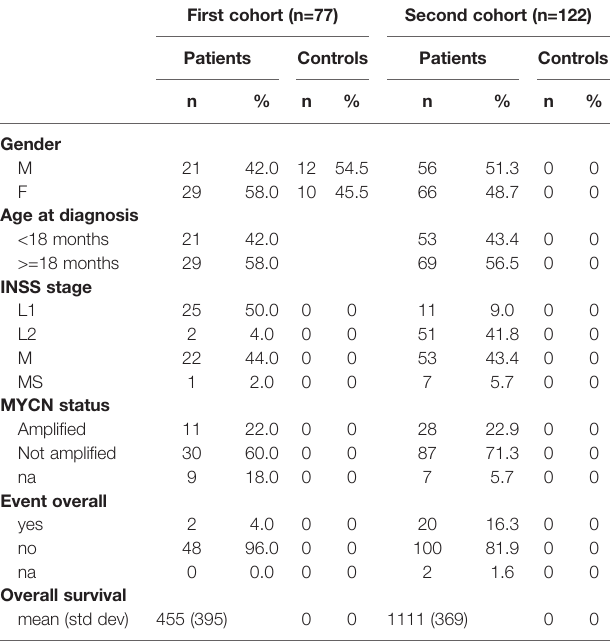
TABLE 1 | Clinical characteristics of the patients and the control subjects included in the study. First cohort